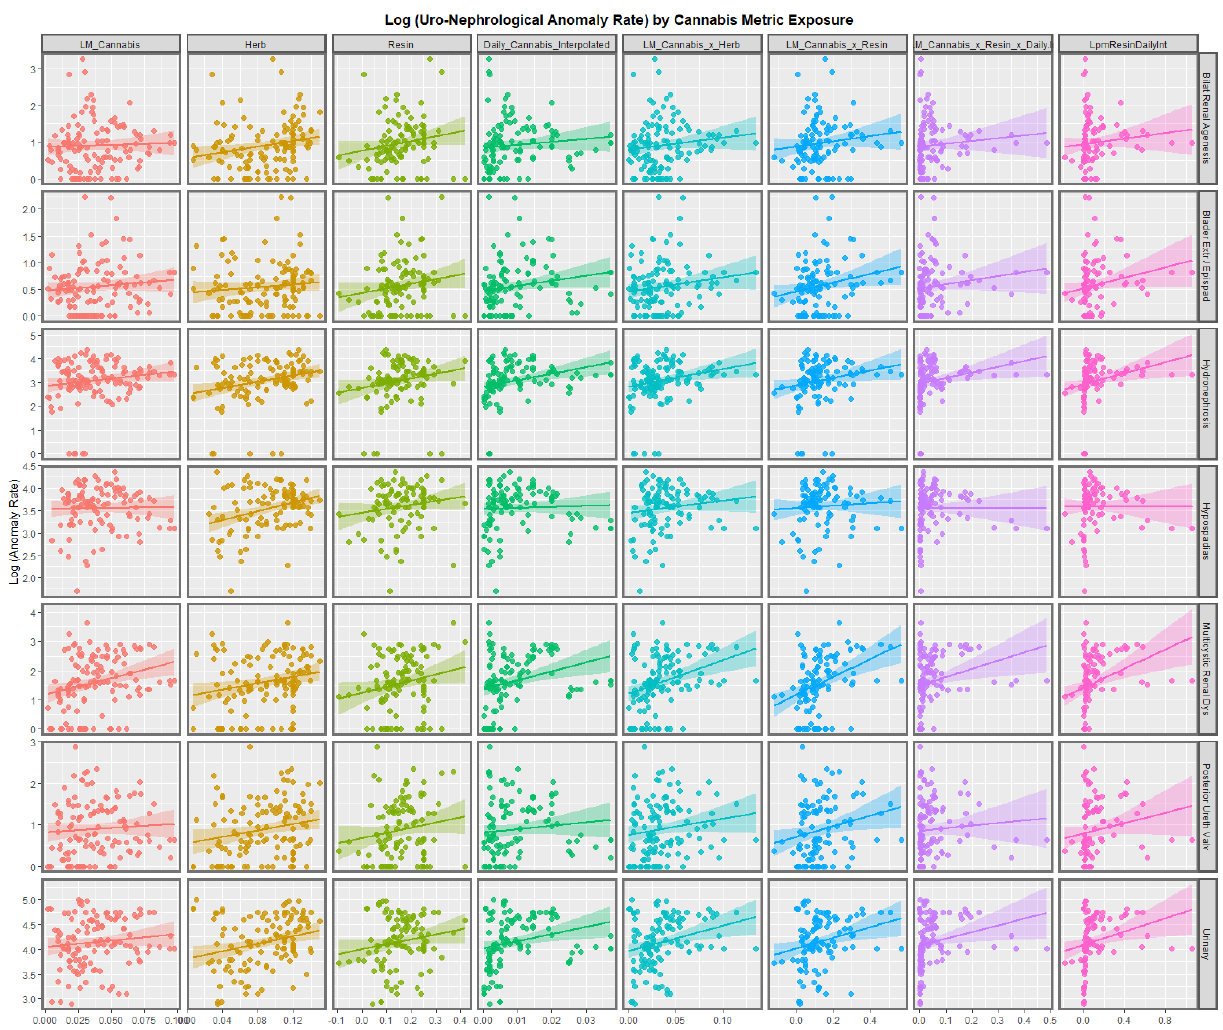
Figure 2. Bivariate plots of selected uronephrological congenital anomalies against various metrics of cannabis exposure.